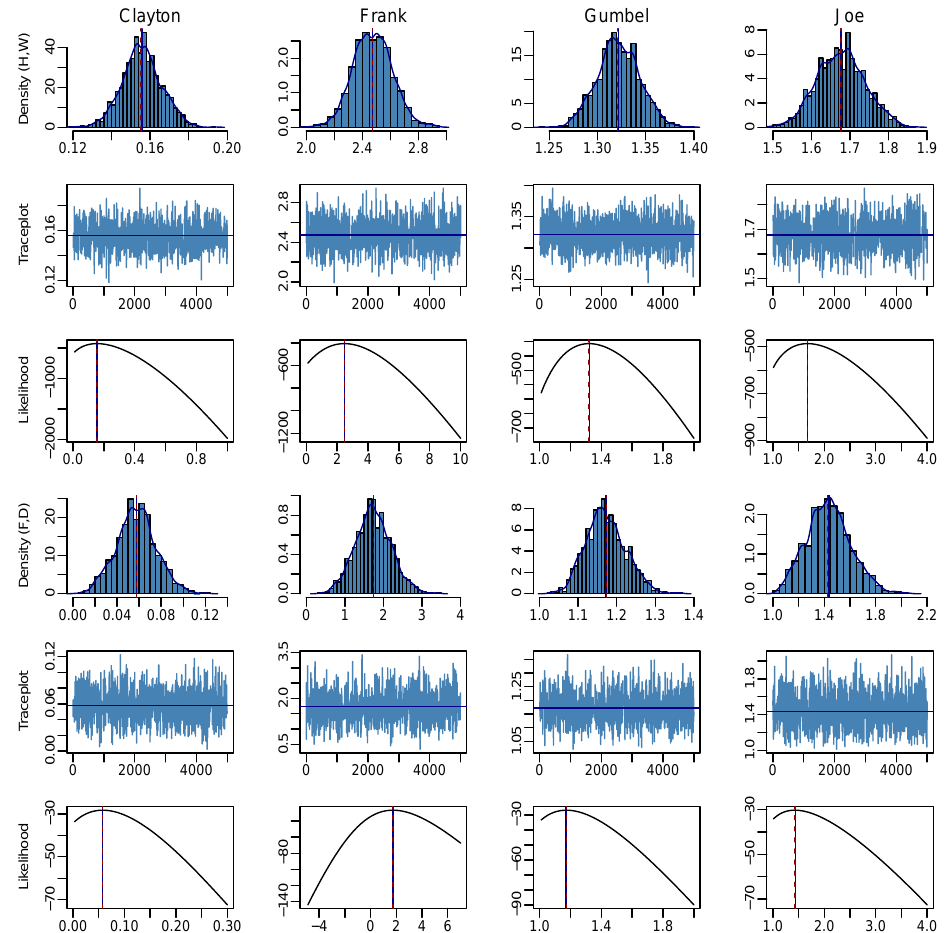
Figure 3. MCMC posterior density, accepted parameter ( α ) traceplots and likelihood function for estimation of the Clayton, Frank, Gumbel and Joe dependence parameters. Results for (H,W) and (F,D), given in rows 1–3 and 4–6, respectively. MCMC estimates given by blue solid line, and MLE estimates by red dashed